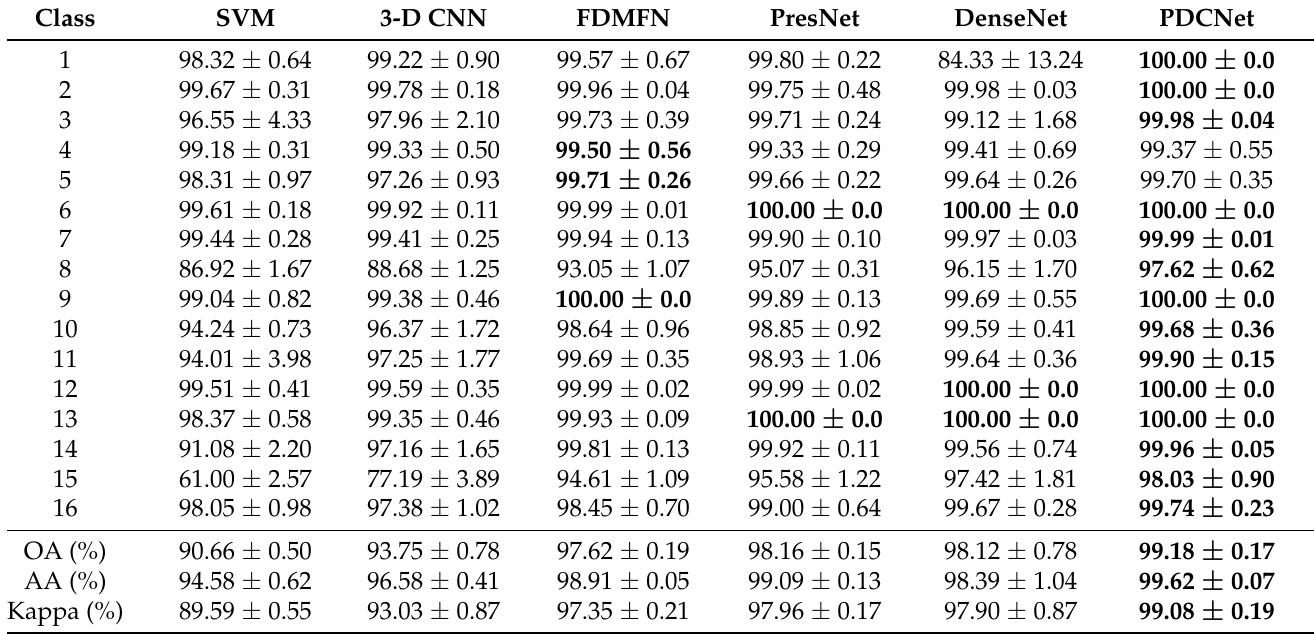
Table 10. The classification results for the SV dataset based on 2% training samples. The best results are highlighted in bold